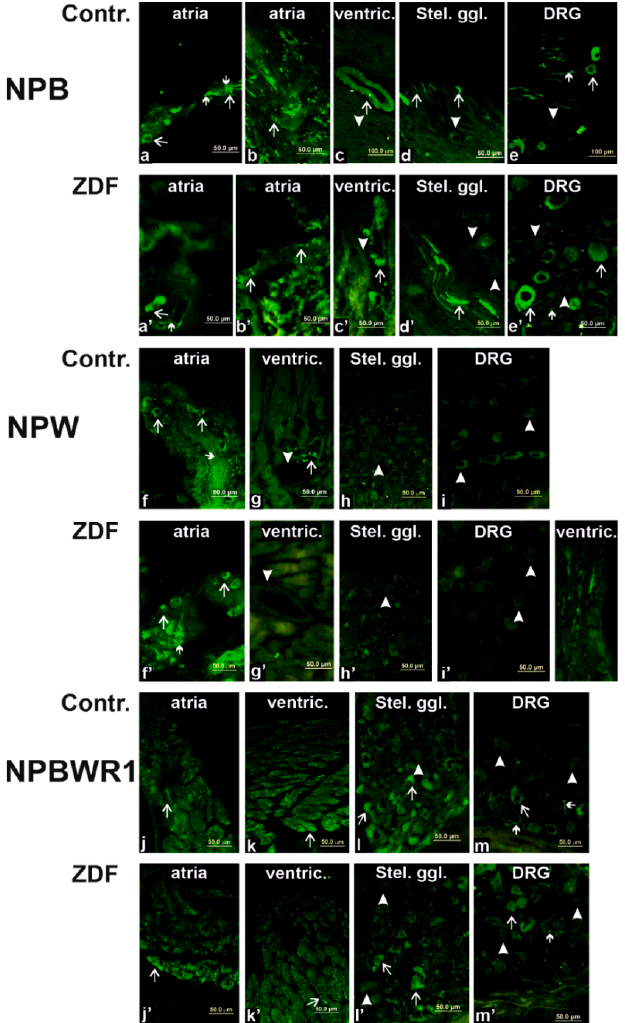
Figure 4. Immunofluorescence for neuropeptide B (NPB), neuropeptide W (NPW), and receptor 1 for NPW and NPB designed as NPBWR1 in the rat heart (atria and ventricles), stellate ganglia, and dorsal root ganglia (DRG) of the control and Zucker diabetic fatty (ZDF) rats. Within atria ( a , a’ , b , b’ ), antiserum against NPB exerted specific immunoreactivity (IR) in neuronal bodies and nerve fibers (some of them marked by arrows) in between cardiomyocytes and near-to-heart ganglia. Within ventricles ( c , c’ ), smooth muscle cells of coronary arteries exerted specific IR. Stellate ganglia ( d , d’ ): NPB-IR nerve fibers (some of them marked by arrows) and NPB-negative nerve cell bodies (arrowheads). DRG ( e , e’ ): NPB-IR some nerve cell bodies (arrows) and nerve fibers (small arrows), some nerve cell bodies NPB-negative (arrowheads). Within atria ( f , f’ ), NPW-IR nerve fibers (small arrows) and nerve cell bodies (arrows) are visible. Within ventricles ( g , g’ ), just the very rare NPW-IR nerve fibers (arrows) are present. Smooth muscle cells of coronary vessels ( g , g’ ) does not exert IR with NPW antiserum (arrowheads). No specific NPW-IR is visible in stellate ganglia ( h , h’ ) and DRG ( i , i’ ). Within atria ( j , j’ ) and ventricles ( k , k’ ), NPBWR1 antiserum show IR in the cardiomyocytes cell membrane (some marked by arrows). Stellate ganglia ( l , l’ ): some nerve cell bodies are NPBWR1- IR (arrows) but some are negative (arrowheads). DRG ( m , m’ ): specific NPBWR1-IR is visible in some nerve cell bodies (arrows) and some nerve fibers (small arrows). Other nerve cells are NPBWR1- negative (some of them marked by